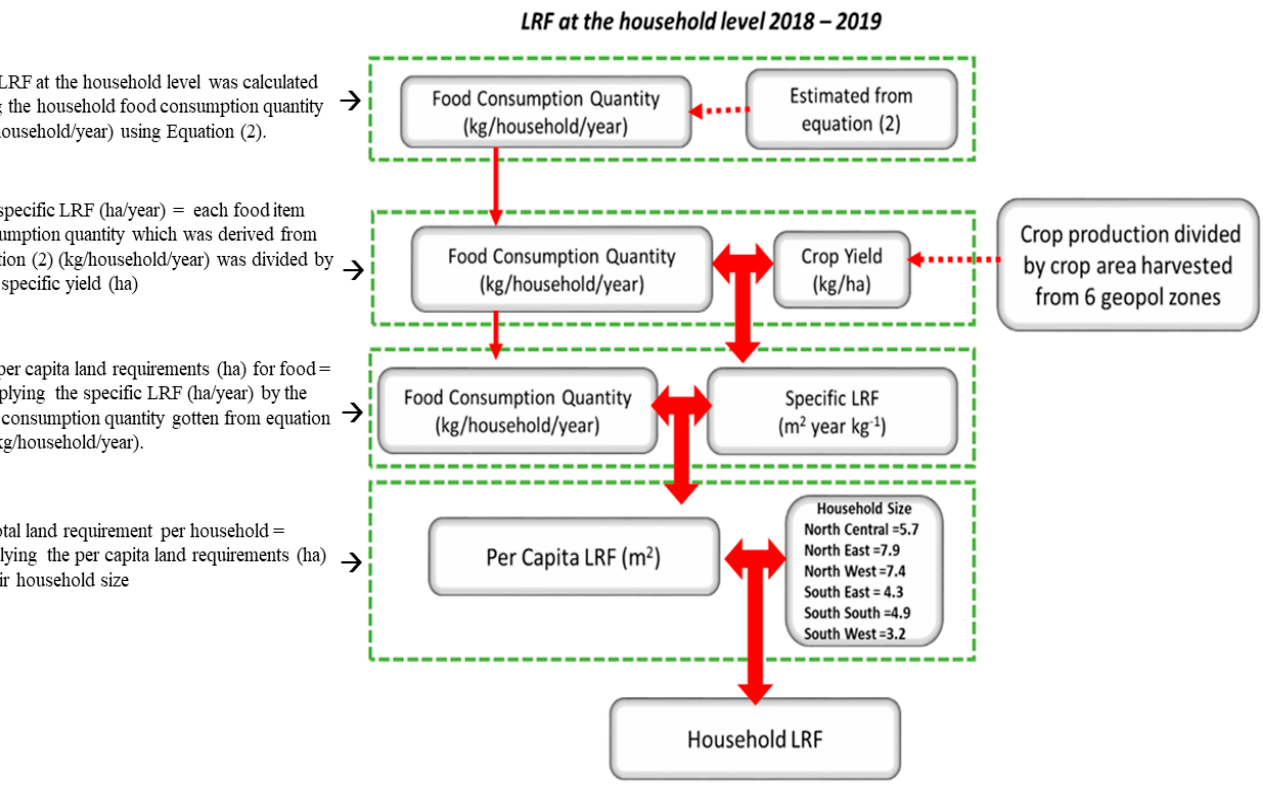
Figure 3. Diagram illustrating land requirements for food calculation in the six geopolitical